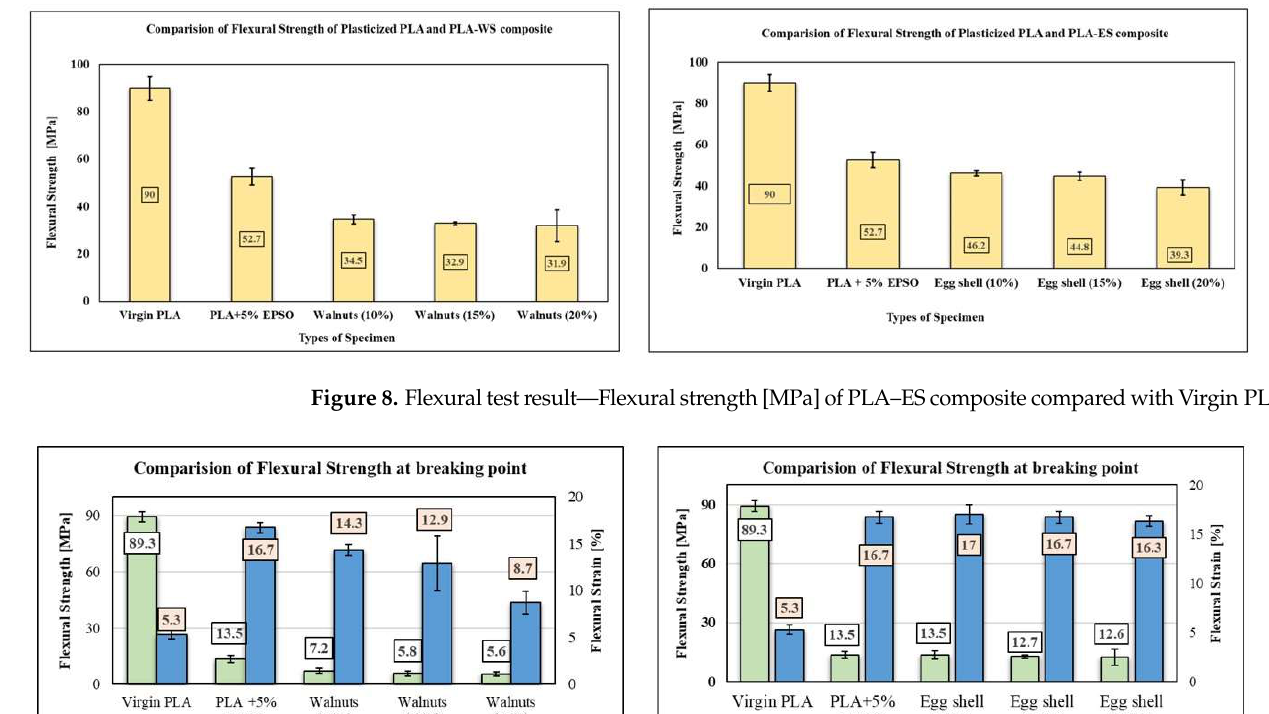
Figure 7. Flexural test result—Flexural modulus [MPa] comparison.